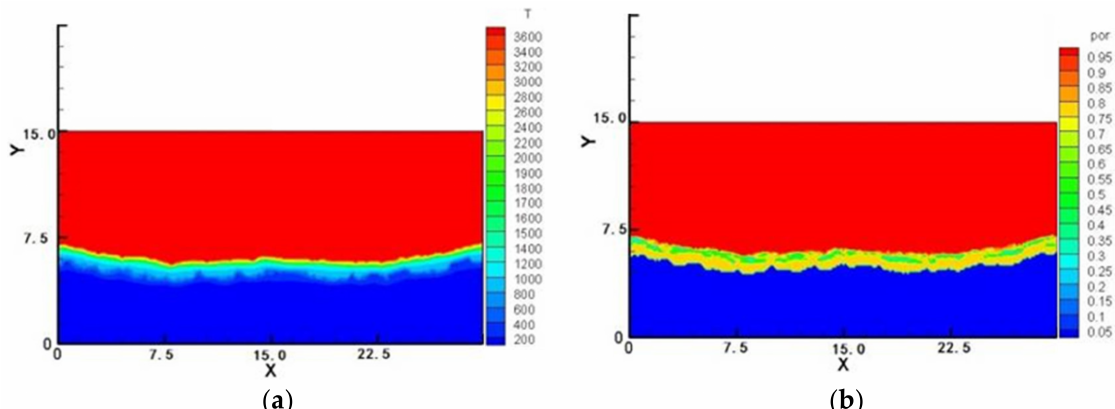
Figure 18. Numerical calculation results under the gas phase velocity of 30 m/s: ( a ) the temperature (°C) distribution contour; ( b ) porosity distribution